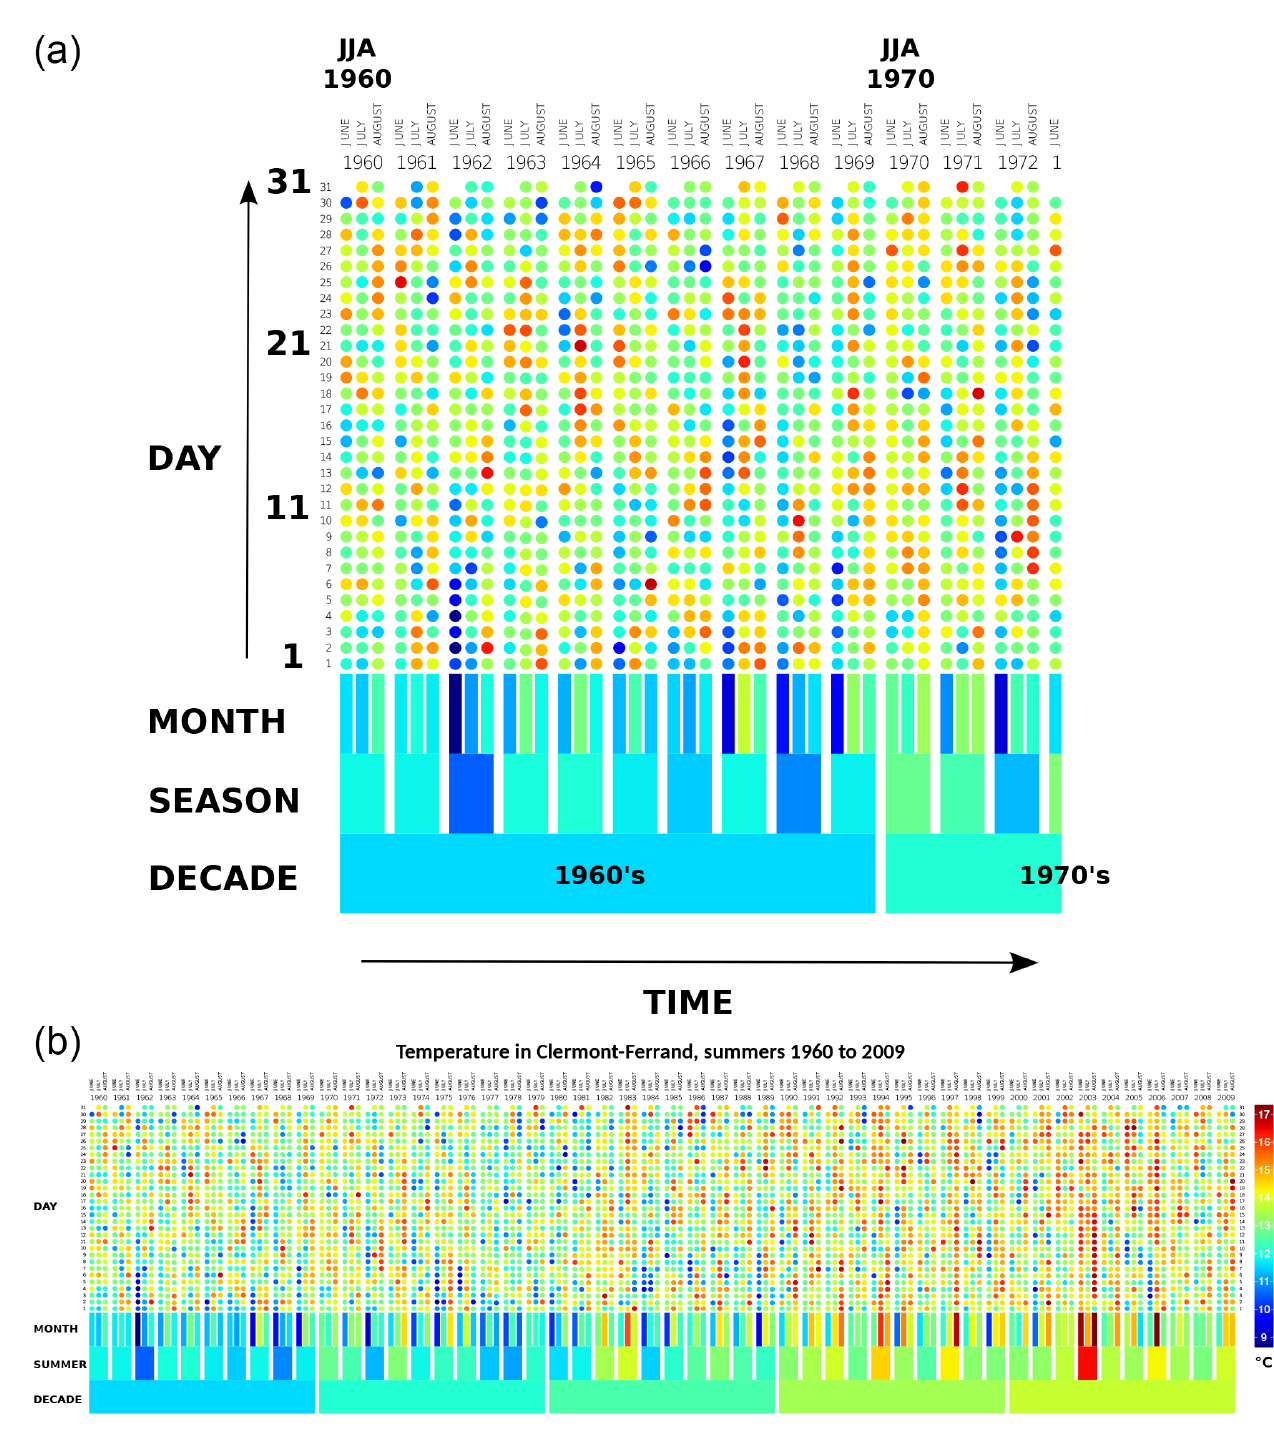
Figure 4. Summer minimal temperature in Clermont-Ferrand. Data are from a new high quality reference dataset (Gibelin et al., 2014) composed of homogenized monthly series and quality controlled daily series. (a) Guidelines on how to read the plot. Colors correspond to temperature values. The upper part of the plot (dots) shows daily temperatures. Each column corresponds to a distinct month (June, July or August). Dots along the vertical show temperatures from day 1 to the last day of the month. The lower part of the plot (rectangles) shows monthly, seasonal and decadal mean temperatures. Each column of dots is averaged and the corresponding monthly mean is shown by an underlying rectangle. Similarly, 3 consecutive monthly means are averaged and the corresponding summer mean is drawn below. Finally, the summer decadal mean is represented using the same color code at the baseline. The time goes from left to right. (b) Summer minimal temperature evolution in Clermont-Ferrand, from 1960 to